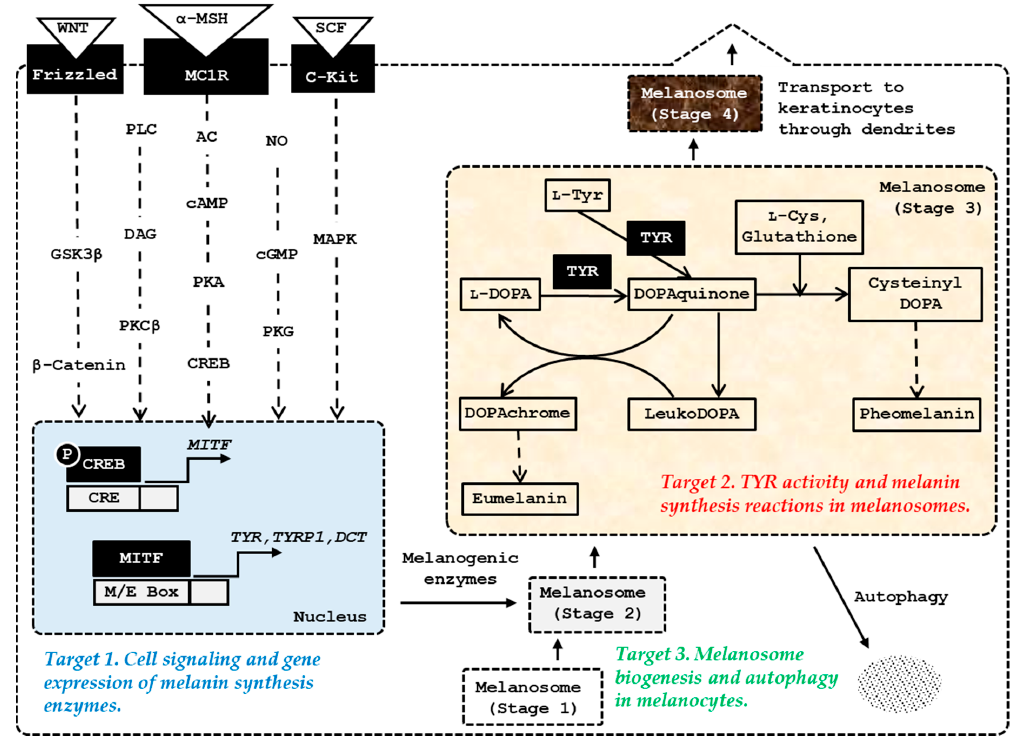
Figure 1. The major targets of amino acids, peptides, and their analogs for the control of skin pigmentation. Microphthalmia-associated transcription factor (MITF) plays a primary role in inducing gene expression of melanogenic enzymes, such as tyrosinase (TYR), tyrosinase-related protein 1 (TYRP1), and dopachrome tautomerase (DCT) in response to various internal and external stimuli. In addition to the α -melanocyte stimulating hormone (MSH) / melanocortin 1 receptor (MC1R) / adenyl cyclase (AC) / cyclic adenosine monophosphate (cAMP) / protein kinase A (PKA) / cAMP-responsive element-binding protein (CREB) pathway, the stem cell factor (SCF) / receptor tyrosine kinase protein, c-Kit / mitogen-activated protein kinases (MAPK) pathway, and WNT / frizzled / glycogen synthase kinase (GSK) 3 β / β -catenin pathway can activate MITF. Other signaling pathways, such as phospholipase C (PLC) / diacylglycerol (DAG) / protein kinase C (PKC) β cascade, and nitric oxide (NO) / cGMP / protein kinase G (PKG) cascade are also involved in the activation of MITF. Melanosome biogenesis occurs through morphologically distinct stages 1, − 2, − 3, and − 4. Melanogenic enzymes matured through post-translational modifications in endoplasmic reticulum and metal-loading in Golgi apparatus are sorted and transported to stage 2 melanosomes. Melanin is synthesized thereafter and the mature stage 4 melanosomes with accumulated melanin are transferred through dendrites to